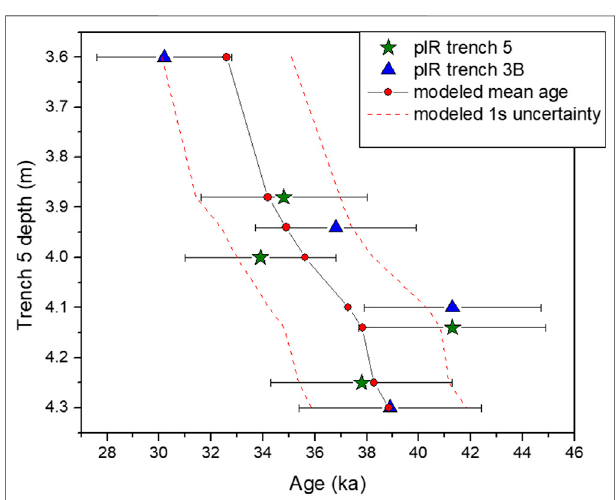
FIGURE 6 | Age-depth plot showing the pIR ages (green stars, blue triangles), the modeled mean ages (red circles), and their upper and lower 1 σ of credibility (dashed red